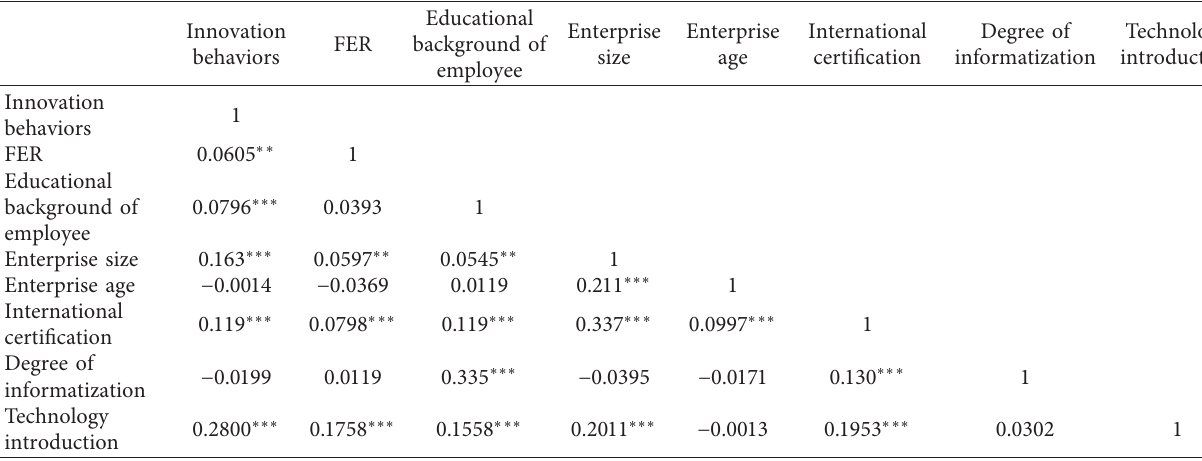
Table 3: Correlation coefficient of main variables.